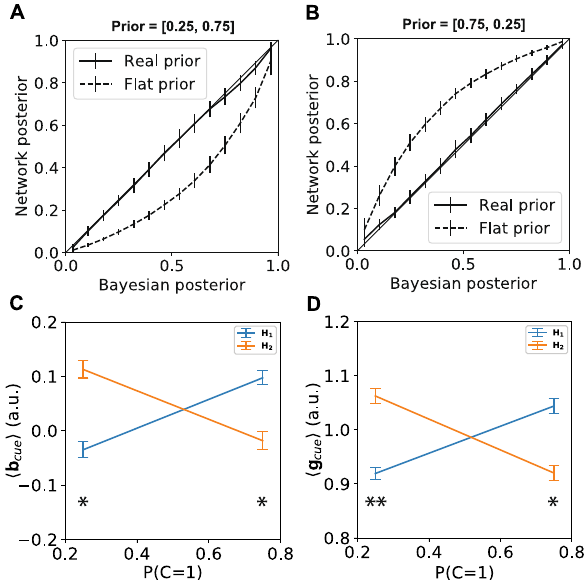
Figure 6. Contextual cue modifies activation thresholds. The frequency with which each class of stimuli was shown depended on a contextual cue. Depending on the cue the prior probability of class 1 and class 2 could either be [0.25, 0.75] or [0.75, 0.25]. (A,B) The network learned to adapt its output probability to reflect the optimal Bayesian estimate given the cue. Error bars represent standard deviation over the validation trials. (C,D) For every hidden neuron, it was determined whether it contributed stronger to class 1 or class 2. The input from the cue to the bias and gain of the hidden neurons was averaged accordingly for both both cues. The cue for the context where class 2 is more likely caused both a higher input to the bias and gain of hidden neurons encoding class 2 and a lower input to the hidden neurons encoding class 1. The opposite effect occurred for the cue for the context where class 1 is more likely. Error bars represent standard error over the units. (* 10 − 10 < p < 10 − 7 , ** p < 10 − 10 ).